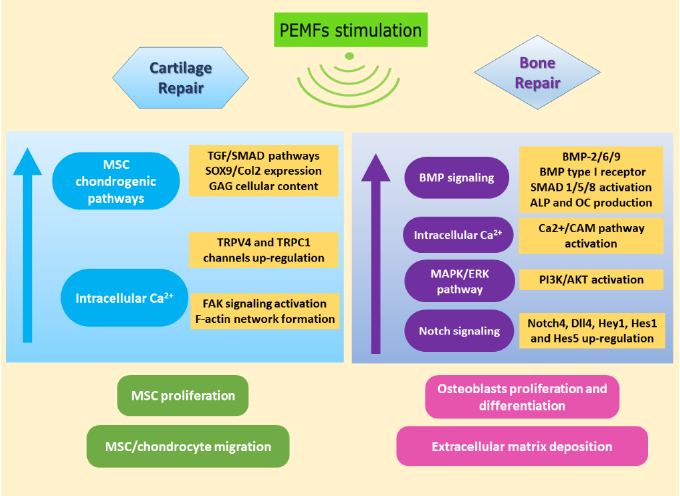
Figure 2. Effects of PEMFs stimulation on MSCs in view of cartilage (left panel) and bone (right panel) repair.